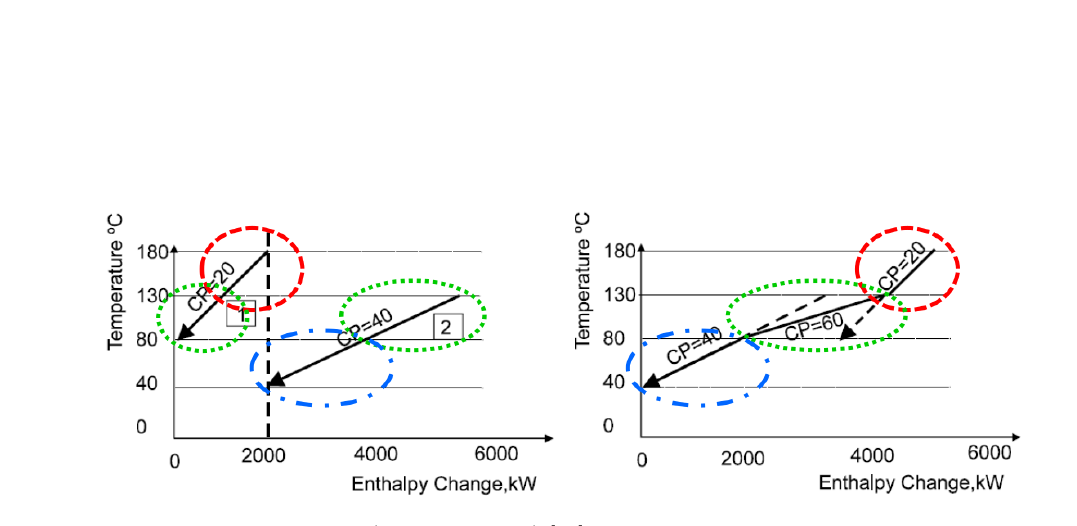
Fig. 29. – Composite curve (load curve only) [10].